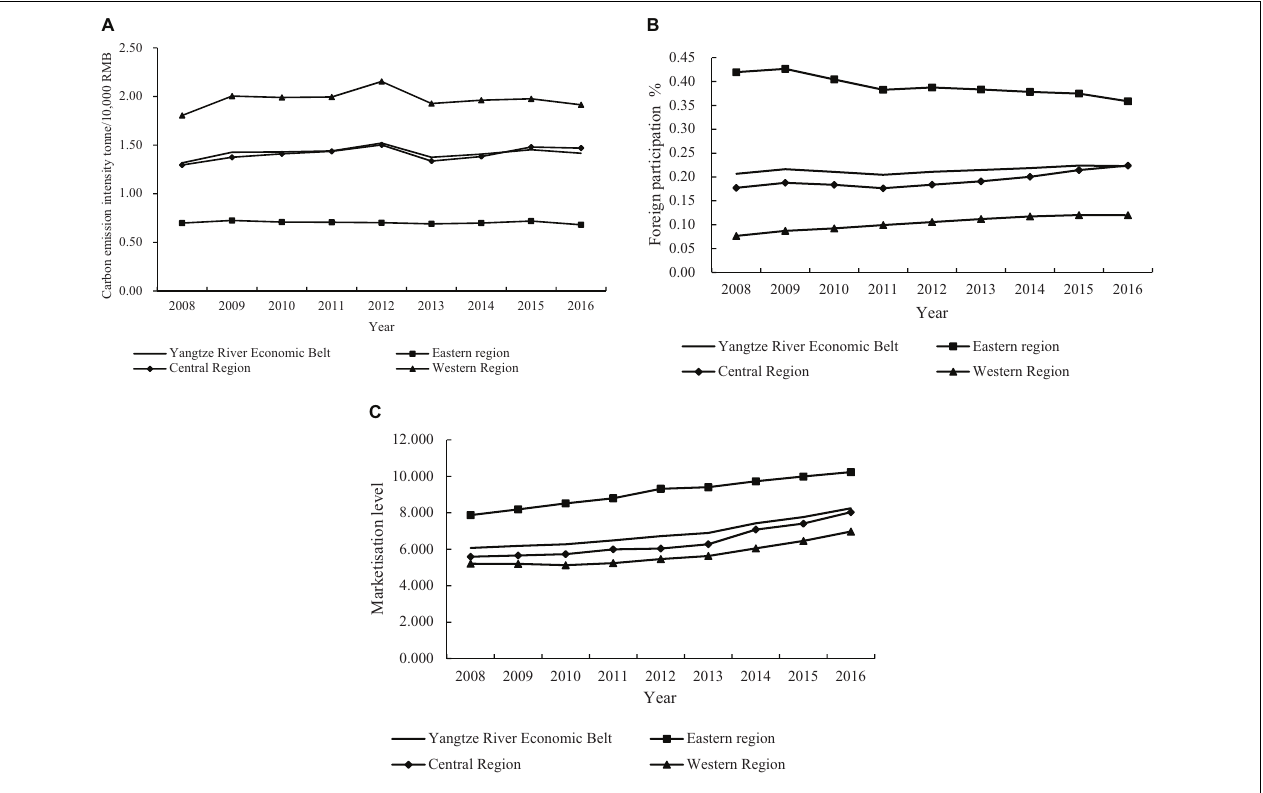
FIGURE 2 | (A) Carbon emissions intensities of Yangtze River Economic Belt and regions (2008–2016). (B) Foreign participation of Yangtze River Economic Belt and regions (2008–2016). (C) Marketisation level of Yangtze River Economic Belt and regions (2008–2016).